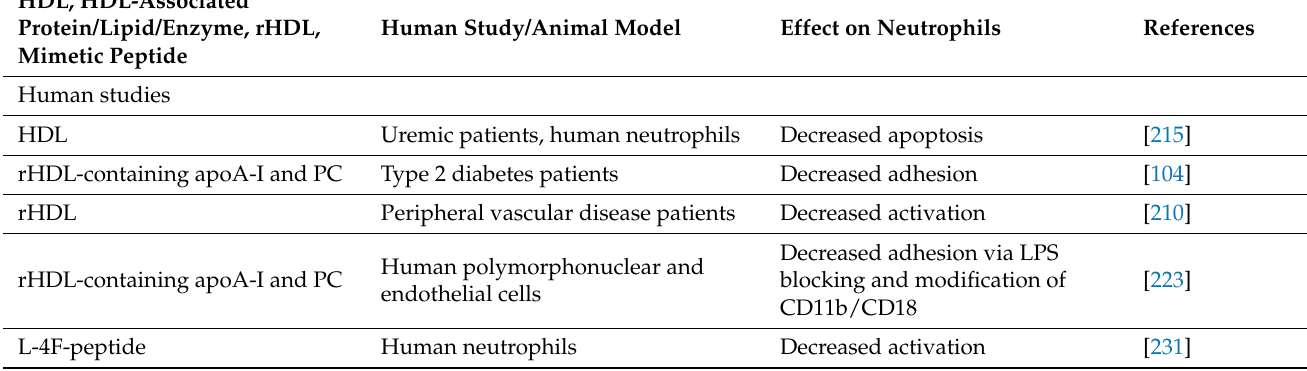
Table 3. Effects of HDL, reconstituted HDL, HDL-associated apolipoproteins, lipids and enzymes or mimetic peptides on neutrophil function in human studies utilizing primary neutrophils and in studies utilizing animal models. HDL, HDL-Associated Protein/Lipid/Enzyme,